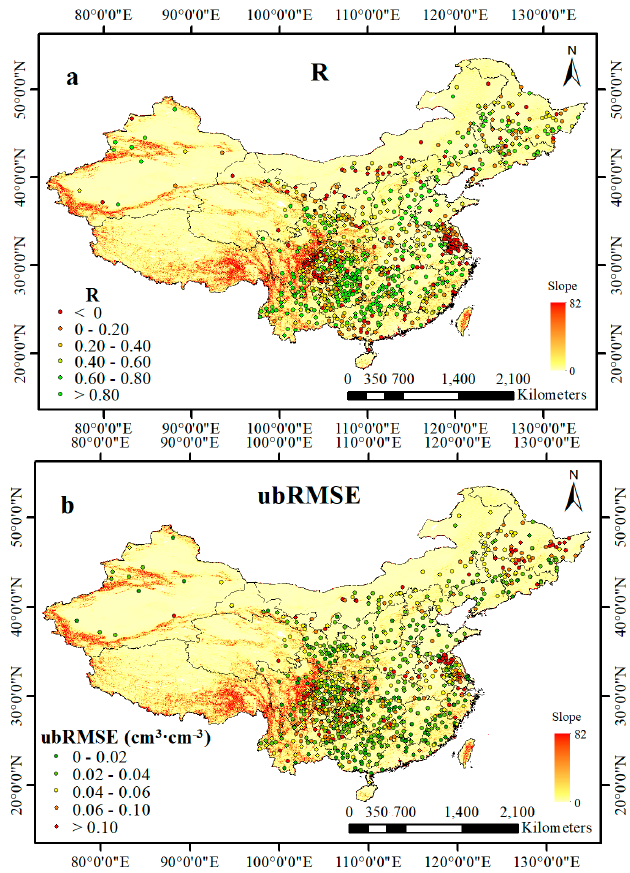
Figure 3. Spatial distribution of the ( a ) Pearson correlation coefficient (R), ( b ) unbiased root mean square error (ubRMSE) between the SMAP and in situ SM at 893 SM stations in China (1 April 2016–30 September 2016). Locations of the 893 monitoring stations are projected onto slope gradient map of China.